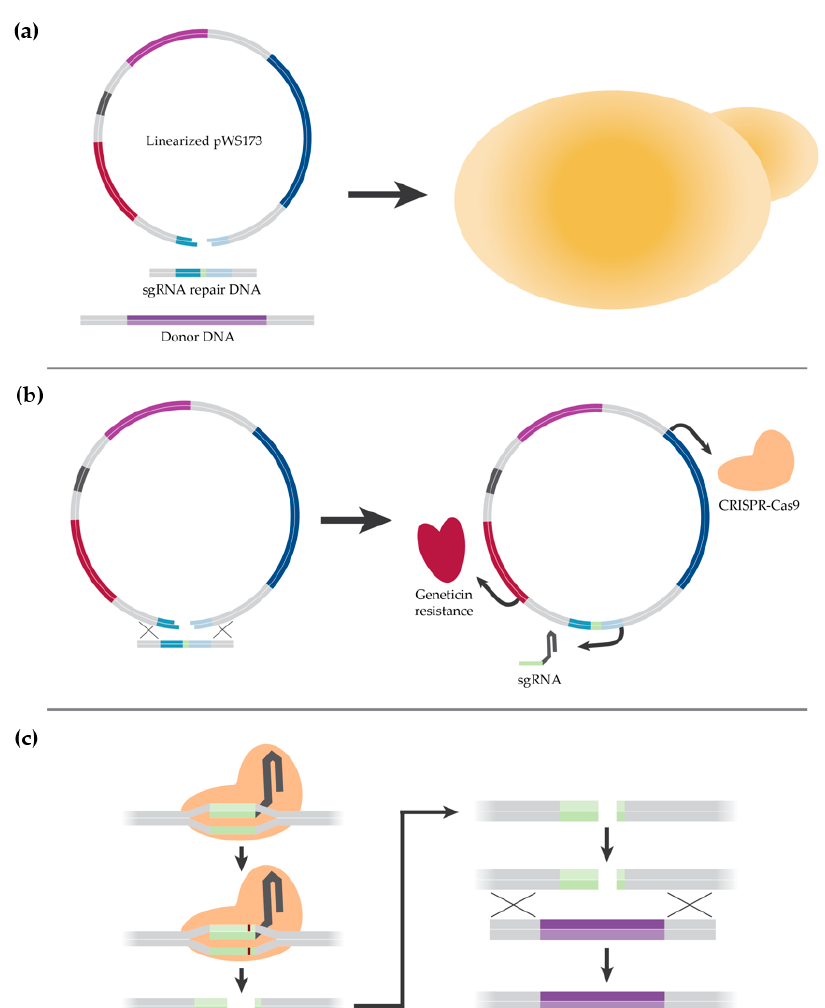
Figure 2. Schematic of DNA components which are transformed in yeast ( a ) and in vivo repair of pWS173, and subsequent expression of CRISPR-Cas9, sgRNA, and G418 resistance cassettes ( b ). The CRISPR-Cas9 ribonucleoprotein recognizes the genomic target sequence and cleaves the site, resulting in a double-stranded DNA break in the genomic DNA. Subsequent homology directed repair with the exogenous donor DNA results in successful genome editing ( c